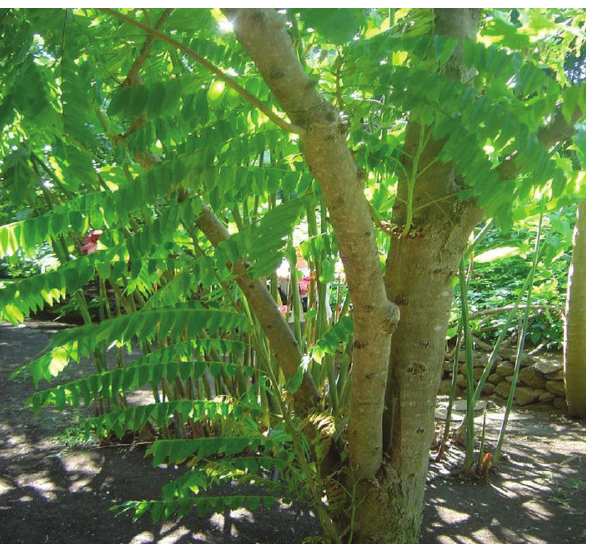
Figure 3: Formation of plant extract of Plum fruit: (a) dried seeds, (b) organic extract, (c) filtered solution (fruit